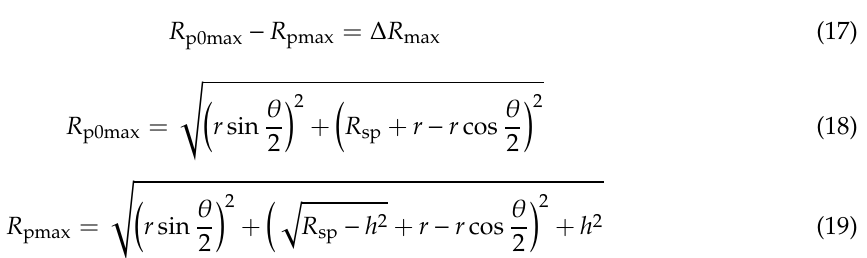
Table 1. The ArcSAR system parameters